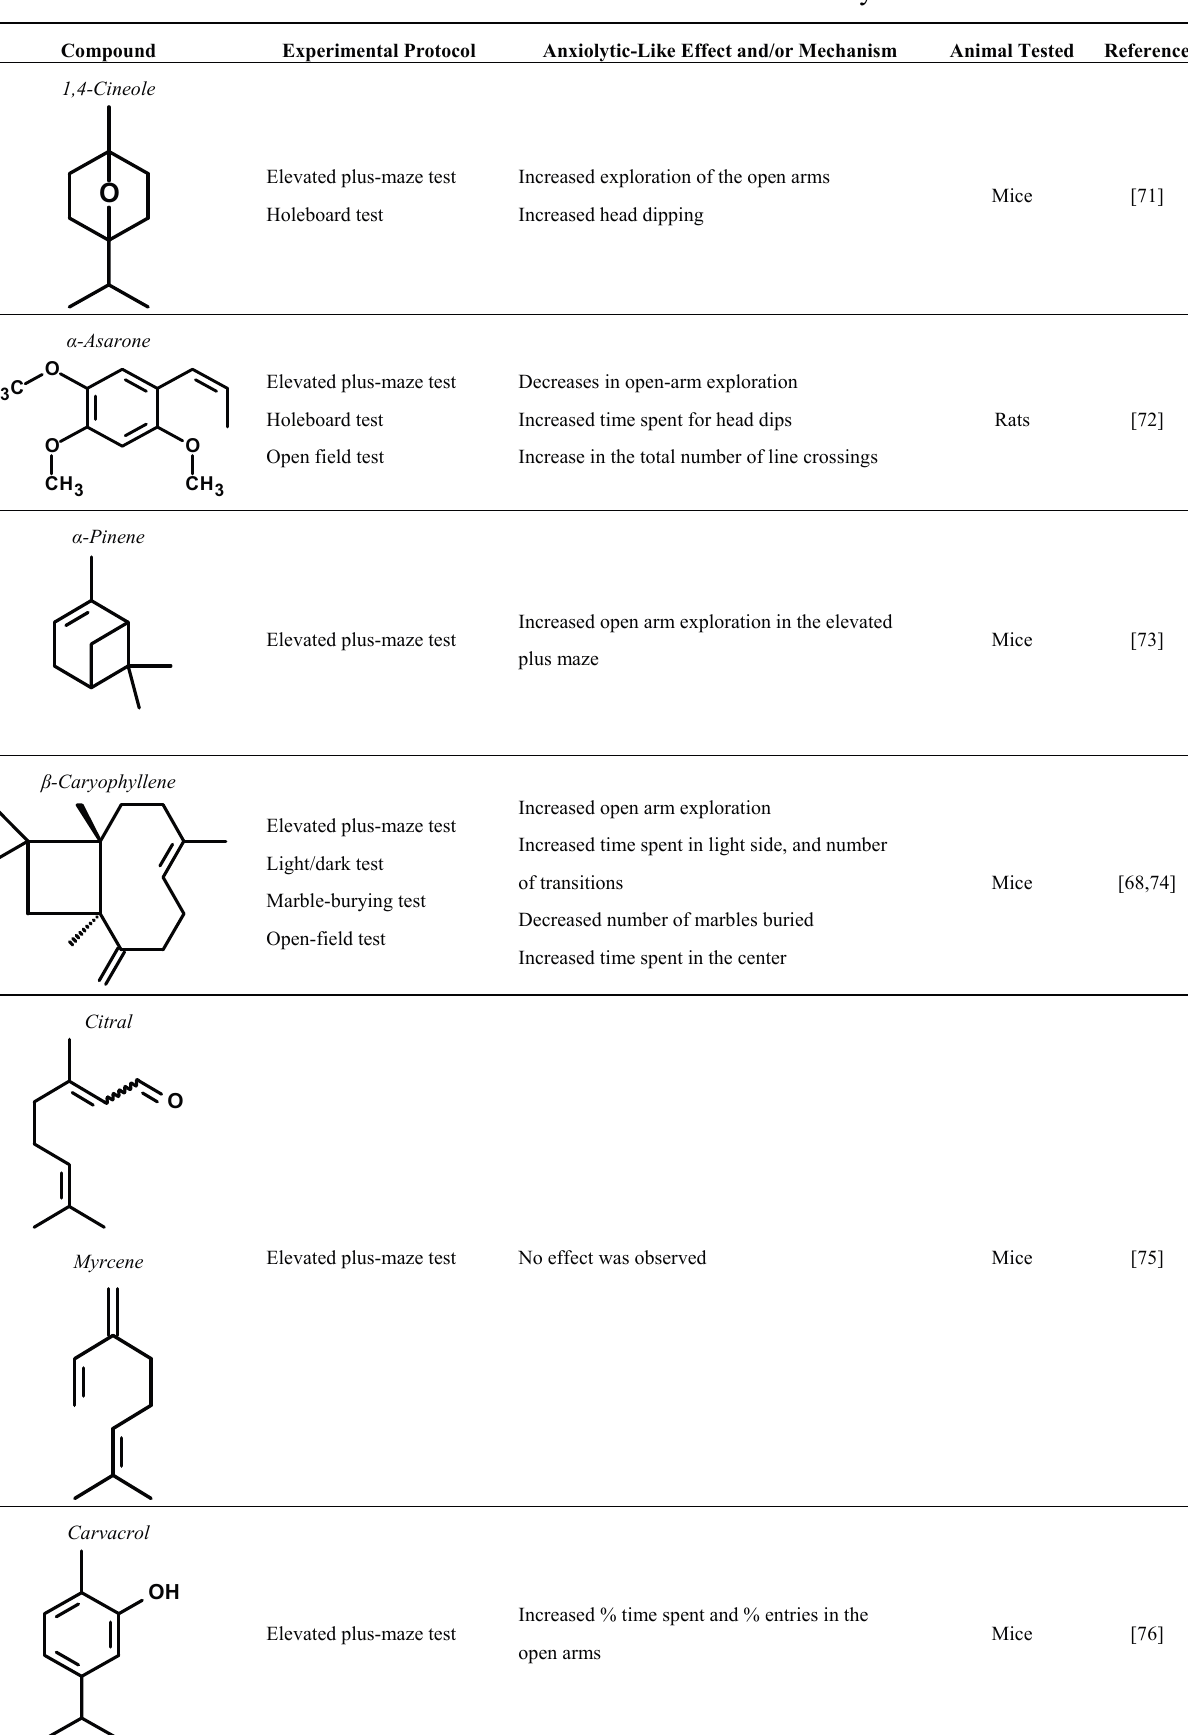
Table 2. Constituents isolated from essential oils with anxiolytic-like